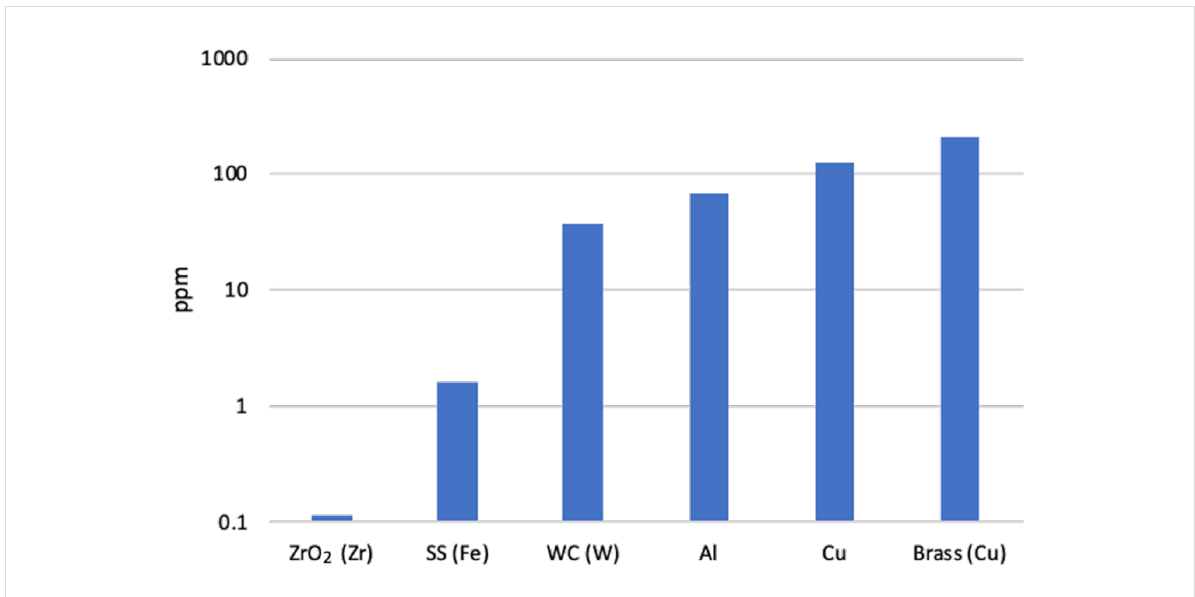
Figure 6: Metal contamination of milled chitin determined by ICP–OES, as a function of the milling medium. The contaminating element is provided in parenthesis.